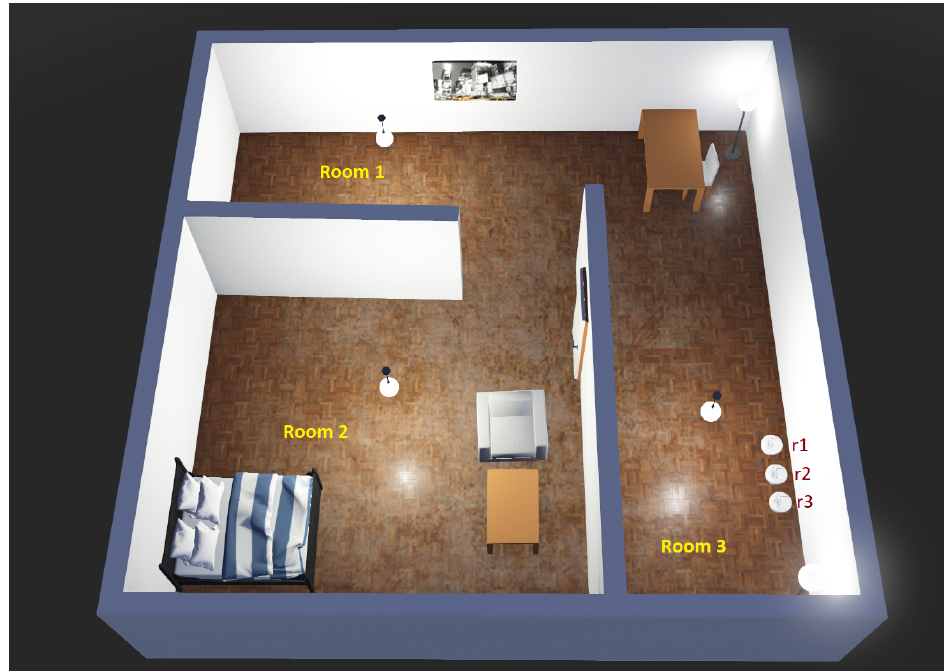
Figure 12. An illustration of multi-robot task allocation: there are 3 iRobot Roombas ( r 1– r 3)